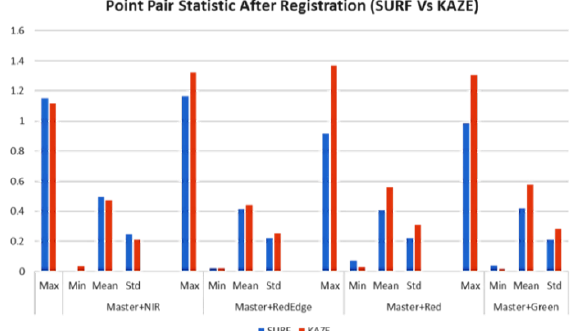
Figure 12. Point pair statistic of many-to-one band registration